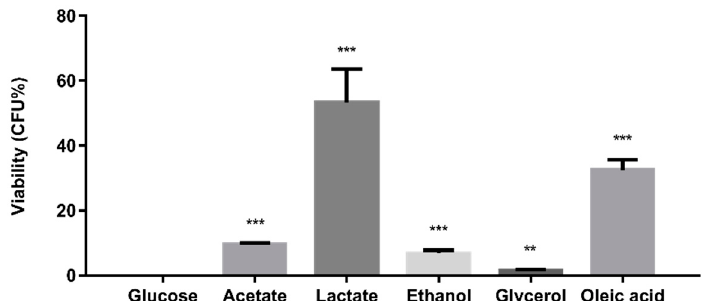
Figure 4. Alternative carbon sources reduce the susceptibility of C. glabrata to amphotericin B. Results are presented as means ± SD. ** p < 0.01 and *** p < 0.001 were considered statistically significant relative to glucose-grown cells.